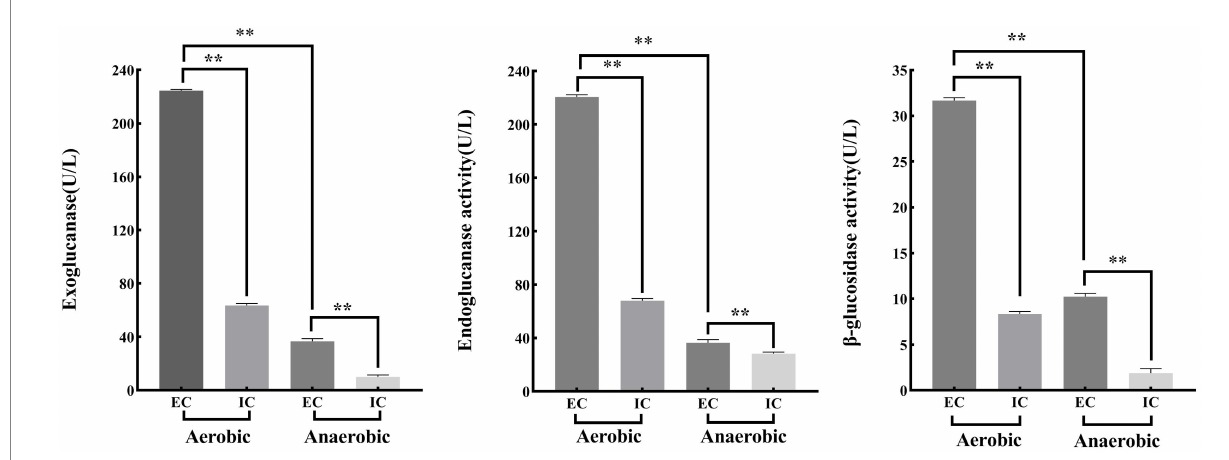
FIGURE 2 Optimal condtions of straw degradation of strain ZJW-6.